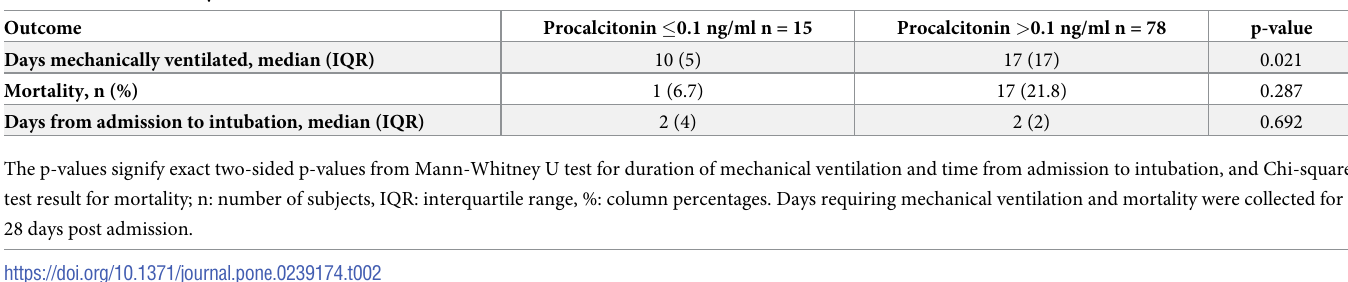
ables included in the regression model were not significantly associated with the duration of mechanical ventilation.